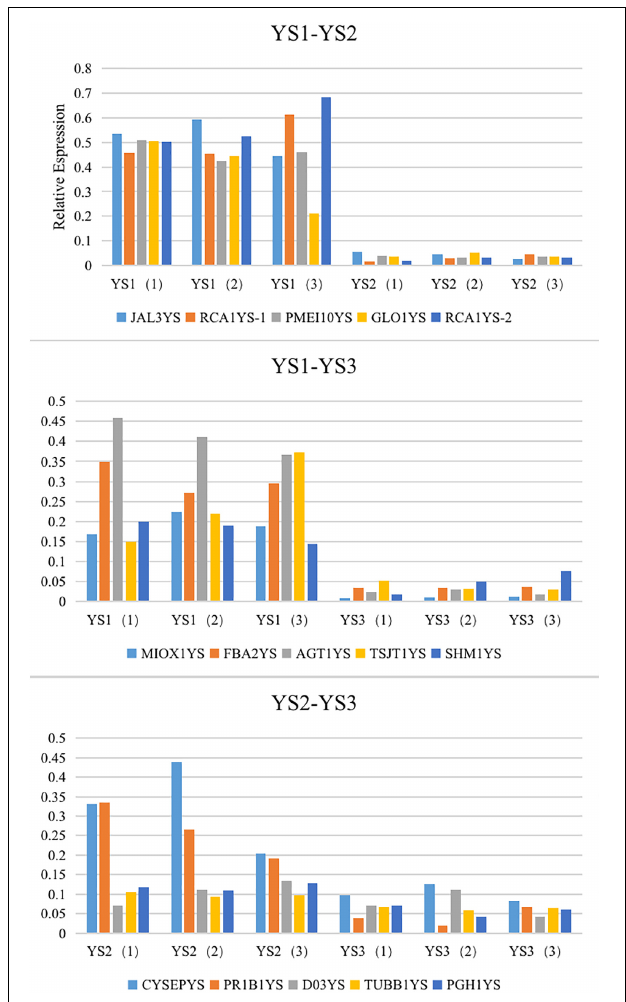
FIGURE 12 | The expression profiles of 15 transcripts in C. dichrum by qRT-PCR.